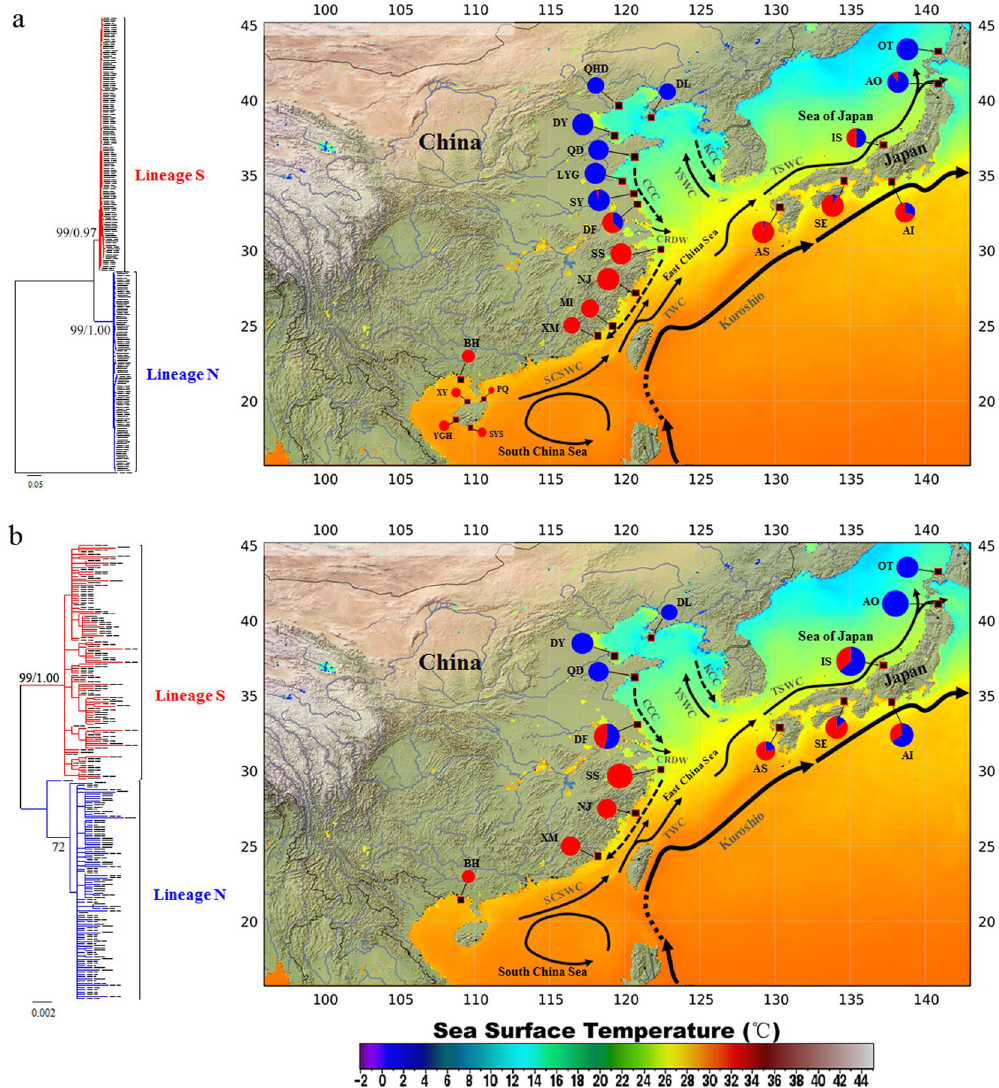
Figure 1. Sample locations and relative frequency of two genetic lineages inferred from mtDNA COI ( a ) and nrDNA ITS ( b ). For each dataset, the corresponding maximum-likelihood (ML) and Bayesian inference (BI) trees are also presented. Numbers above branches represent maximum likelihood bootstrap (left) and Bayesian posterior probabilities (right) for the two major lineages. The map also presented Sea Surface Temperature (SST) in the NW Pacific in winter (2002–2011), which was modified from ref. 78. SCSWC, South China Sea Warm Current; TWC, Taiwan Warm Current; CCC, China Coastal Current; CRDW, Changjiang River Diluted Water; YSWC, Yellow Sea Warm Current; TSWC, Tsushima Warm